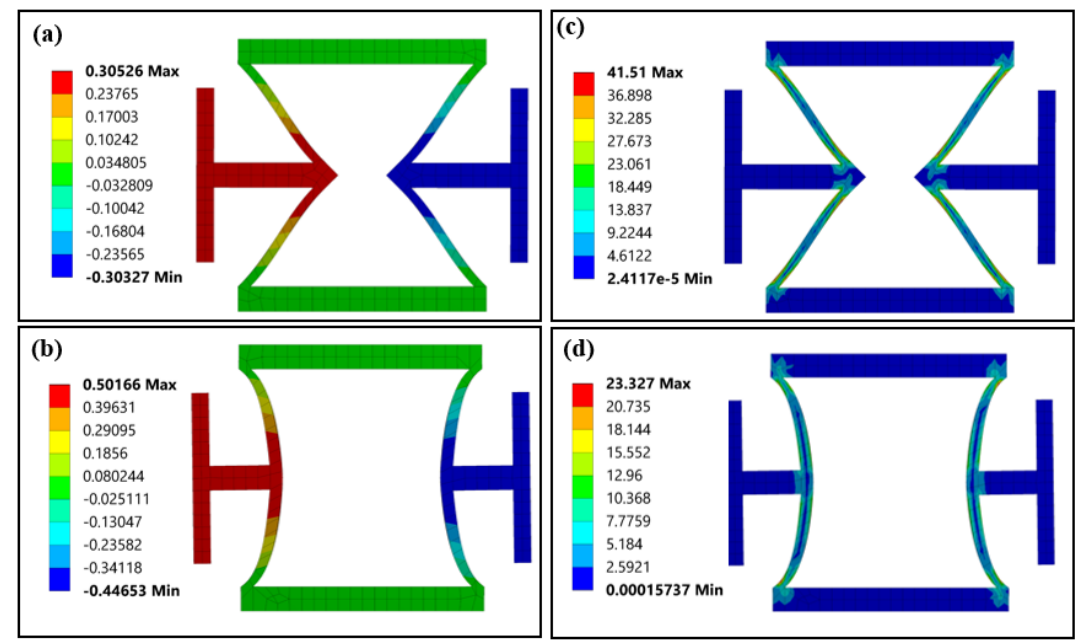
Figure 4. The FEA results of the re-entrant and CS-based units under uniaxial tension (strain 0.05): ( a ) transverse displacement (unit: mm) of the re-entrant unit, ( b ) transverse displacement (unit: mm) of the CS-based unit, ( c ) internal stress distribution (Von Mises equilibrium stress) of the re-entrant unit (unit: MPa) and ( d ) internal stress distribution (Von Mises equilibrium stress) of the CS-based units (unit: MPa).